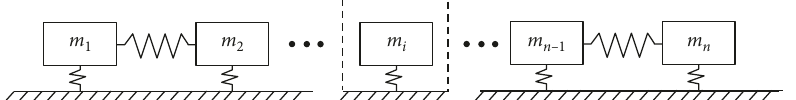
Figure 3: System dynamics model of the concrete foundation.